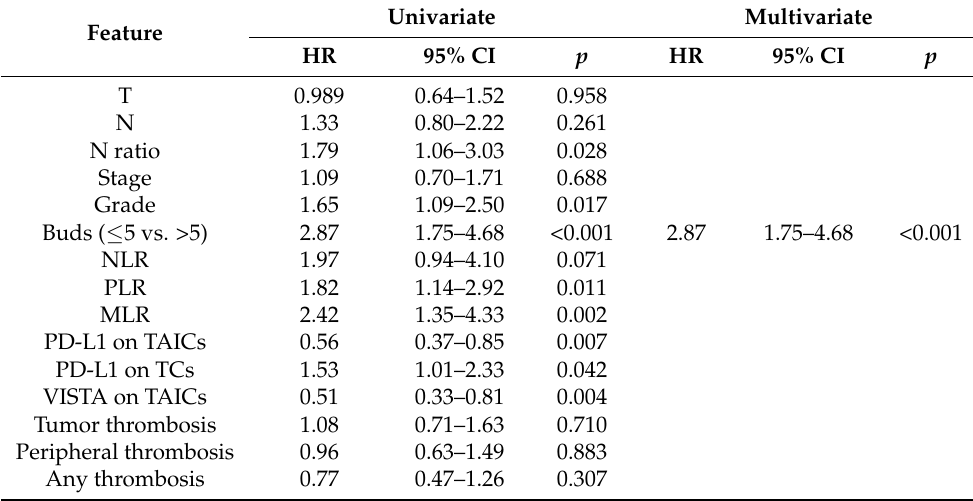
Table 4. Uni- and multi-variate proportional hazard Cox regression analysis of prognostic markers in pancreatic cancer.